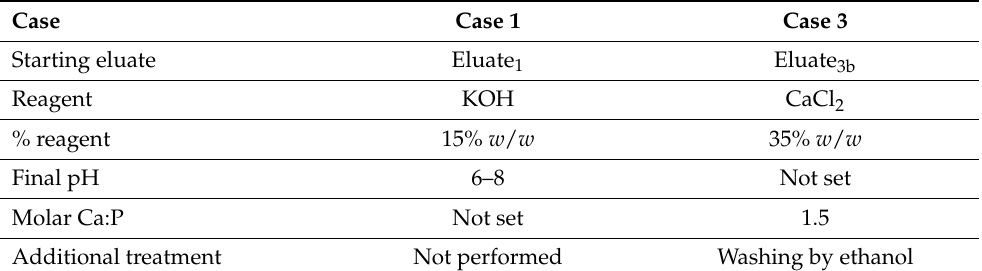
Table 6. Operating conditions of the precipitation tests for case 1 and case 3 in the experimental campaign (eluate 1 : from case 1, step a; eluate 3b : from case 3, step